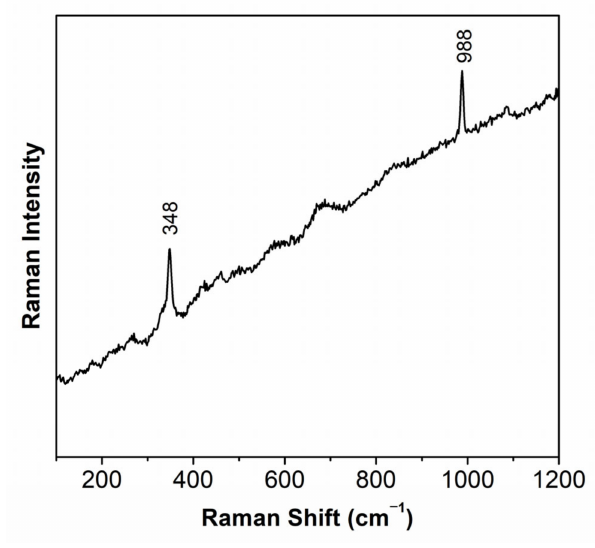
Figure 6. Raman spectra of the white color, identifying the presence of lithopone. The presence of iron and silicon in the brown color detected by micro-XRF indicates the presence of an ocher-based material. However, it was not possible to identify the ocher using Raman spectroscopy. The infrared spectra show a heterogeneous sample in which the following compounds are detected: a material similar to quartz in a complex matrix and barium sulphate with a fingerprint similar to the white color. So it is possible that the pigment is also lithopone, in a proteinaceous binding media, Figure 7.